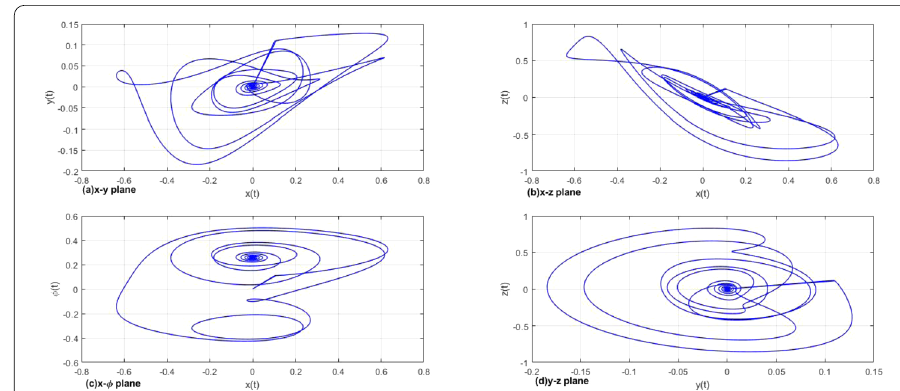
Figure 10 Phase portrait of model (21) for β 3 = 0.11